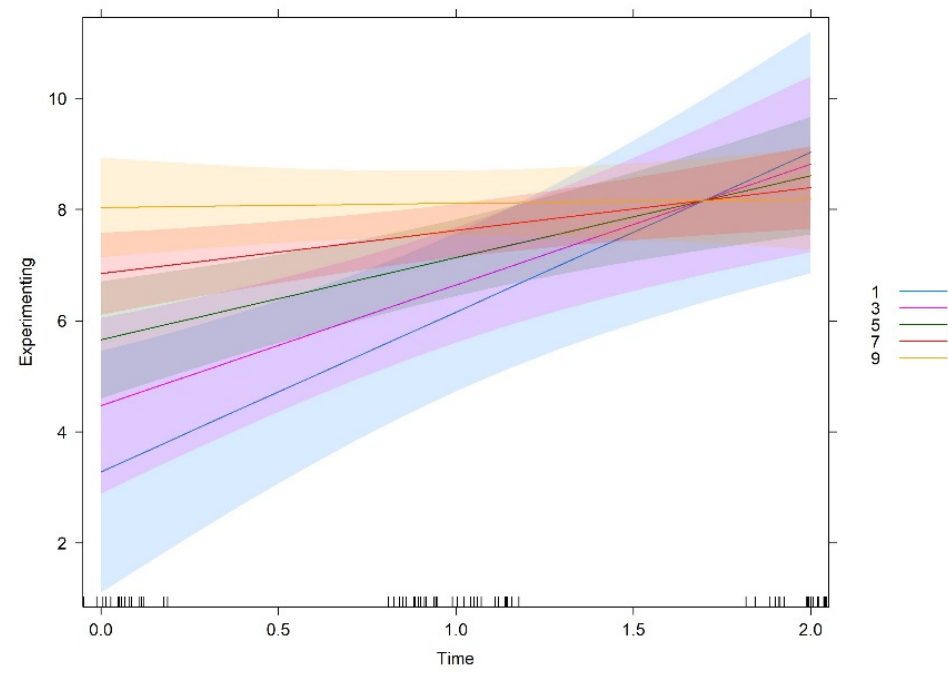
Figure 1. Interaction effect between time and support.